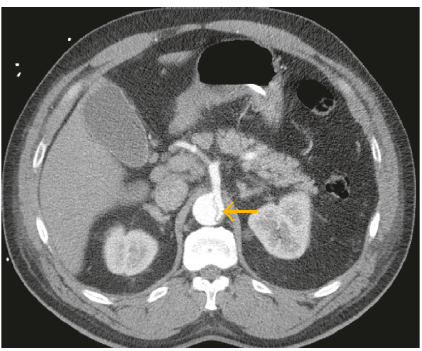
Figure 2: CT angiography showing acute type B aortic dissection with severe narrowing of the true lumen (yellow